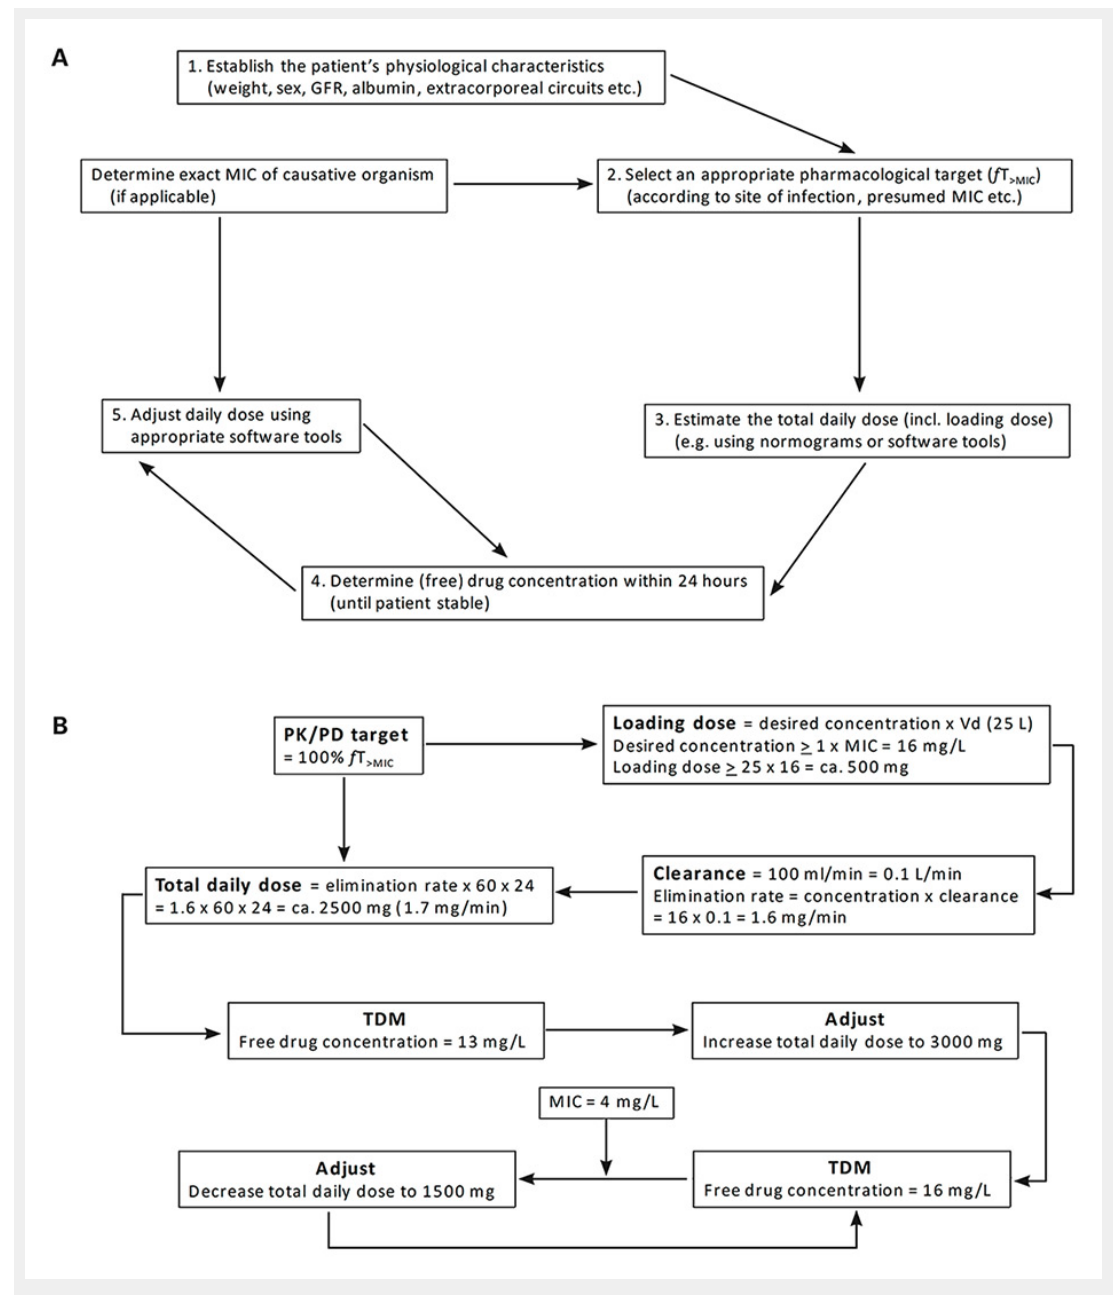
Figure 3 (A) Algorithm for personalised β-lactam dose optimisation in critically-ill patients. (B) Calculation of meropenem dose for empirical and definitive treatment of severe pulmonary sepsis caused by P. aeruginosa in a neutropenic fever patient (38 years old, 70 kg). The following parameters are assumed for this hypothetical calculation: presumed MIC for P. aeruginosa ≤16 mg/L (local surveillance data), calculated creatinine clearance of 100 ml/min, treatment with vasoactive agents. Based on concept from Choi et al. [85]. GFR = glomerular filtration rate; MIC = minimal inhibitory concentration; PK/PD = pharmacokinetics/pharmacodynamics; f T >MIC = time that the free drug concentration is above the MIC; TDM = therapeutic drug monitoring; Vd = volume of